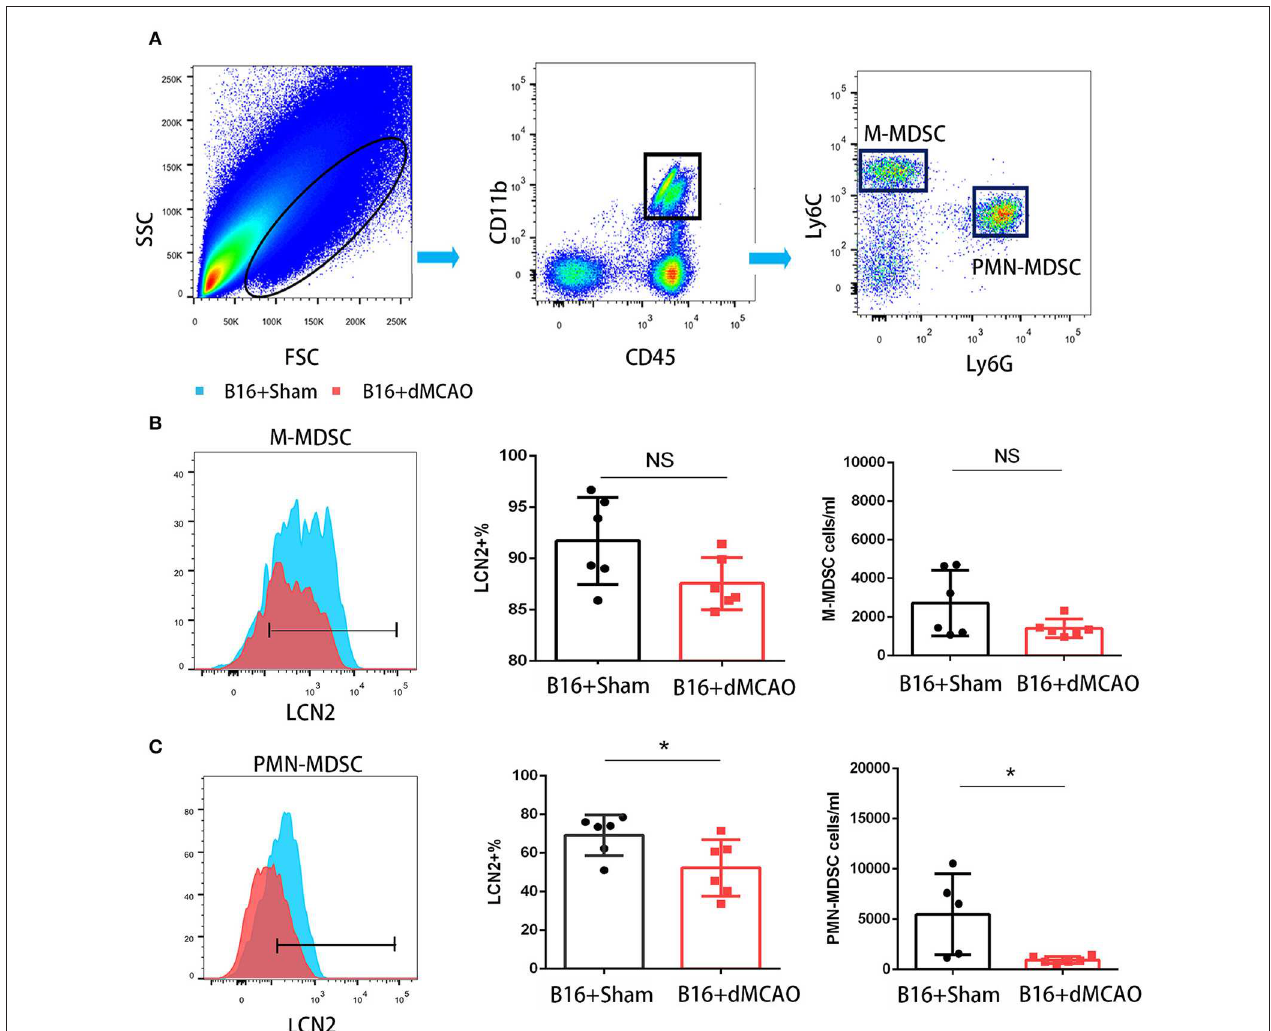
FIGURE 7 | Flow cytometry of LCN2 expression in M-MDSCs and PMN-MDSCs from blood. (A) Gating strategy of the MDSC populations in blood 3 days after sham or stroke surgery. (B,C) LCN2 expression in M-MDSC (CD45 + CD11b + Ly6G low Ly6C hi ) and PMN-MDSC (CD45 + CD11b + Ly6G hi Ly6C low ) in the blood after stroke ( n = 6/group. * P ≤